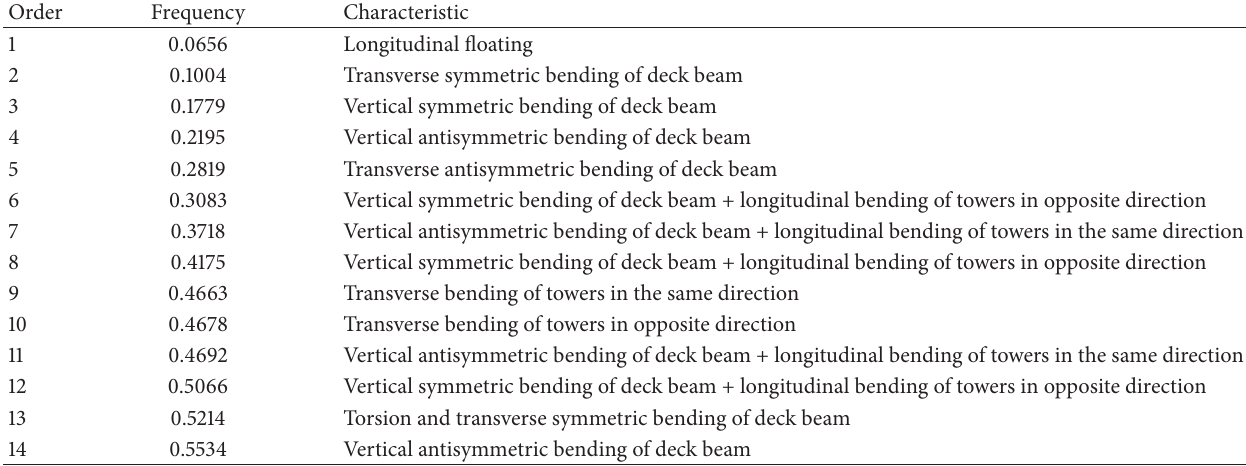
Table 1: Frequencies (Hz) and characteristics of the first 14 modes of the cable-stayed bridge.